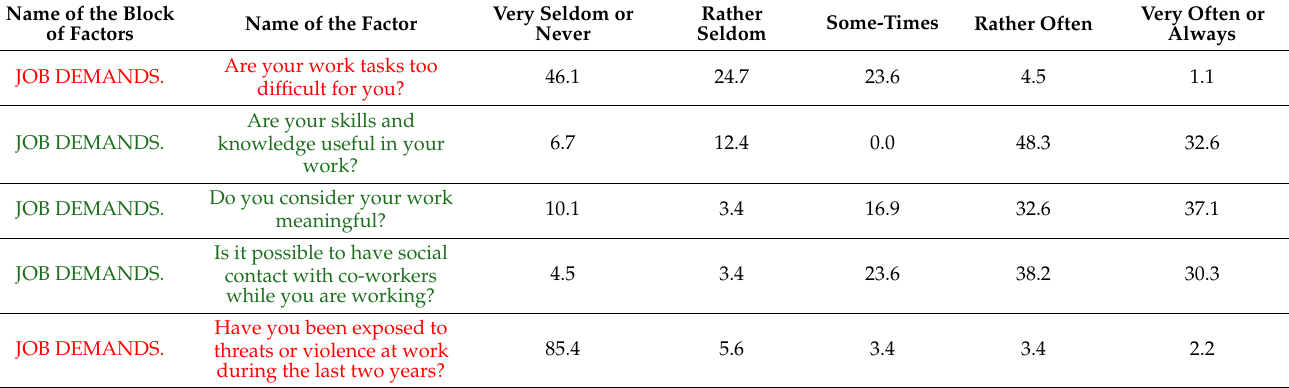
Table 11. Positive psychosocial factors in the work of loggers with shift work organization in the Far North (% of the total